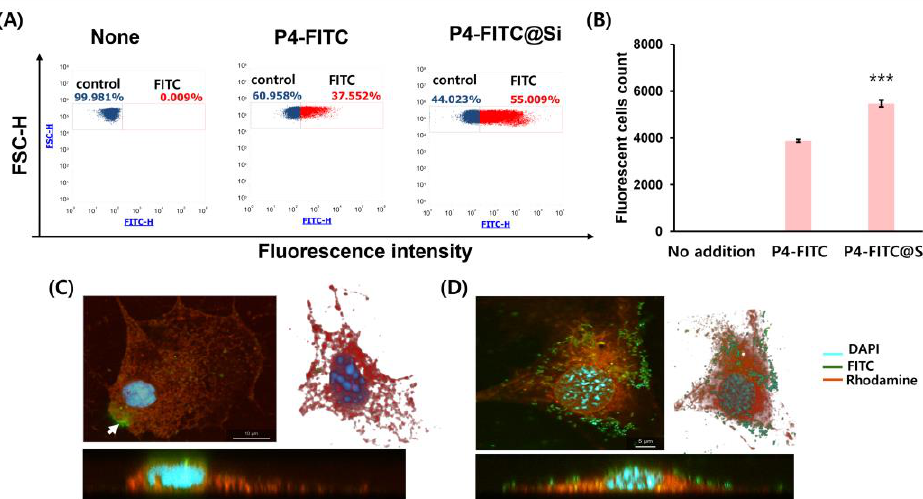
Figure 4. Flow cytometry analysis of cellular uptake of free P4 and P4@Si in MC3T3 E1 cells. Each P4 preparation (P4-FITC accounts for 10% of the total 50 µ g/mL of P4) was treated on MC3T3 E1 in OPTI-MEM medium for 4 h and subsequently washed thrice in PBS after cell harvest. ( A ) The control represents the unlabeled cells. The FITC represents FITC-labeled cells. ( B ) Comparison of the number of fluorescently labeled cells per 10,000 cells between two P4 preparations. *** p < 0.001 vs. P4-FITC. ( C , D ): ( C ) P4-FITC treated cell and ( D ) P4-FITC@Si treated cell. The confocal cell images taken along the XY plane (left image) and z -axis using (below image) STEDYCON microscope. ImageJ software was used to generate 3D reconstructions of the z-stacks confocal images (right image). Scale bar: 10 µ m for ( C ) and 5 µ m for ( D